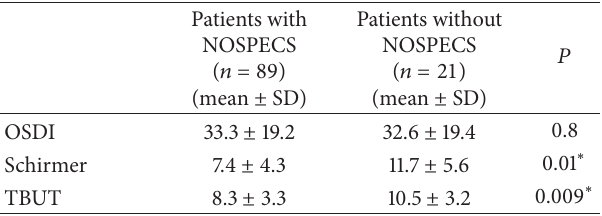
Table 4: Comparison of dry eye between patients with and without NOSPECS